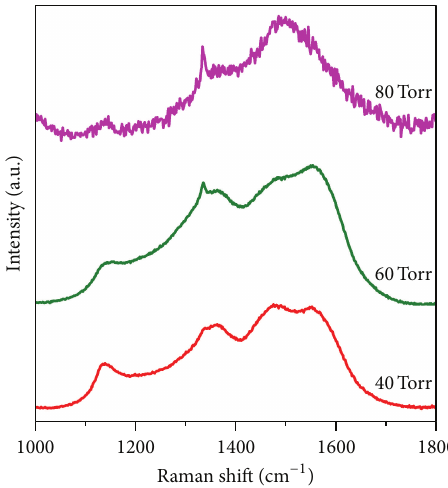
Figure 2: Raman spectra for the diamond films grown at various working pressures under 40 Torr, 60 Torr, and 80 Torr,